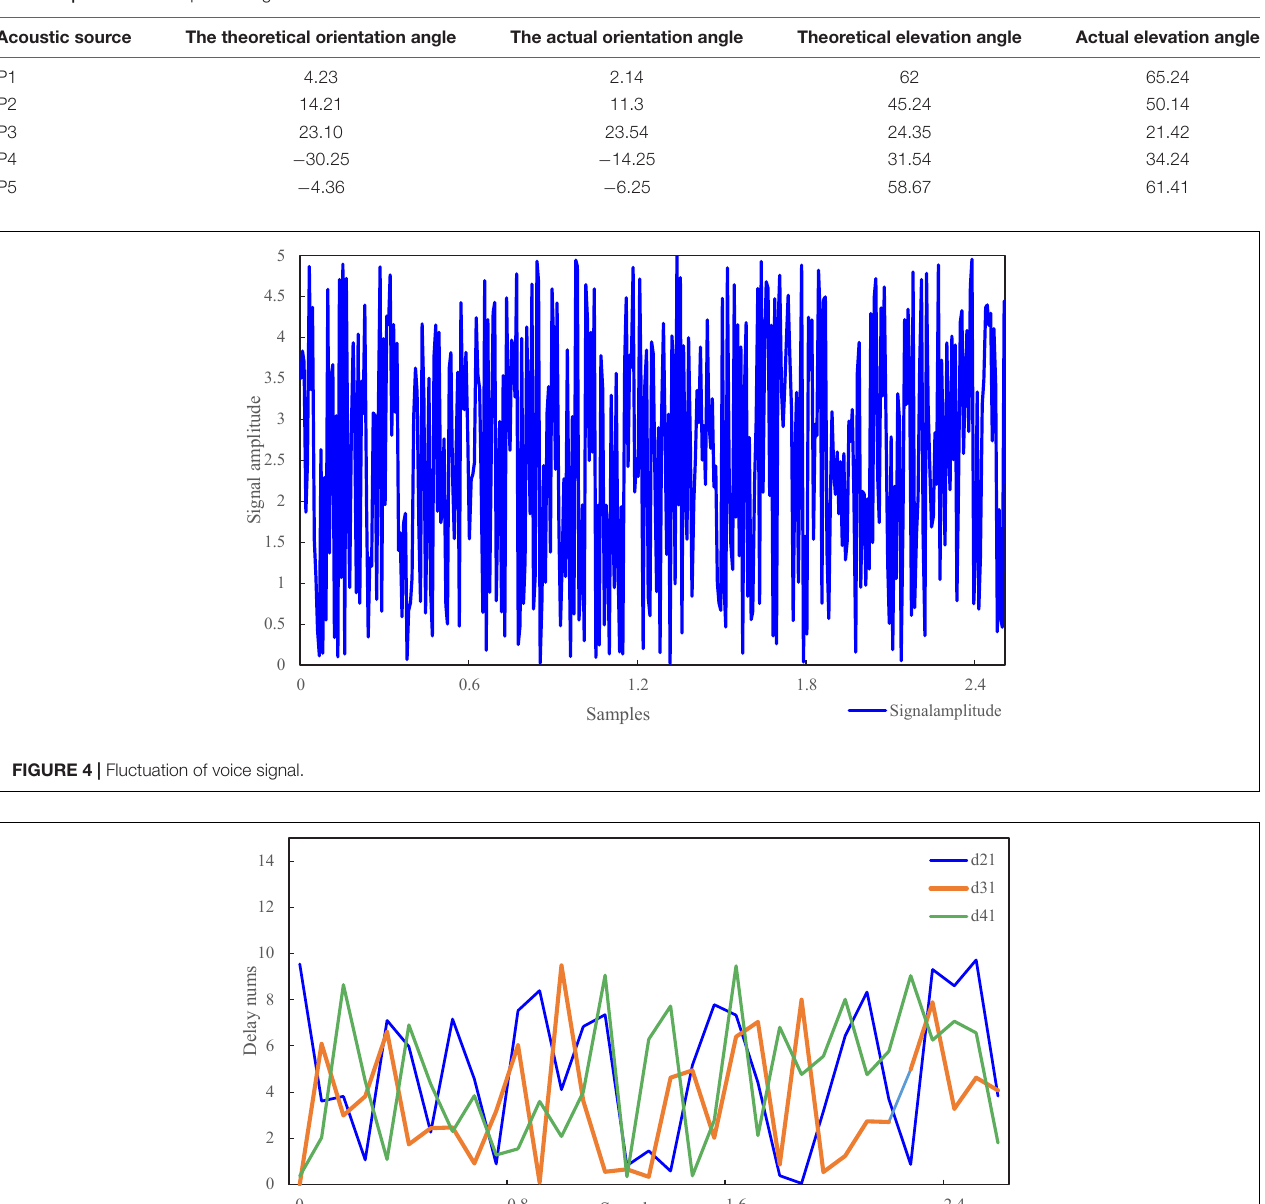
TABLE 2 | Sound source positioning data.